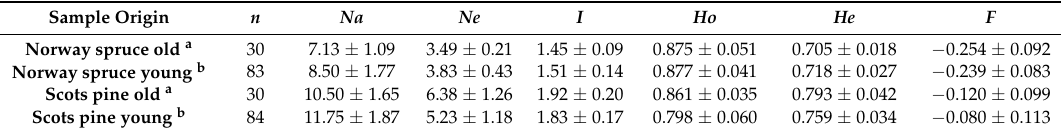
Table 2. Main parameters of genetic diversity, calculated for putatively maternal and self-regenerating Norway spruce ( Picea abies (L.) H. Karst) and Scots pine ( Pinus sylvestris L.) trees.